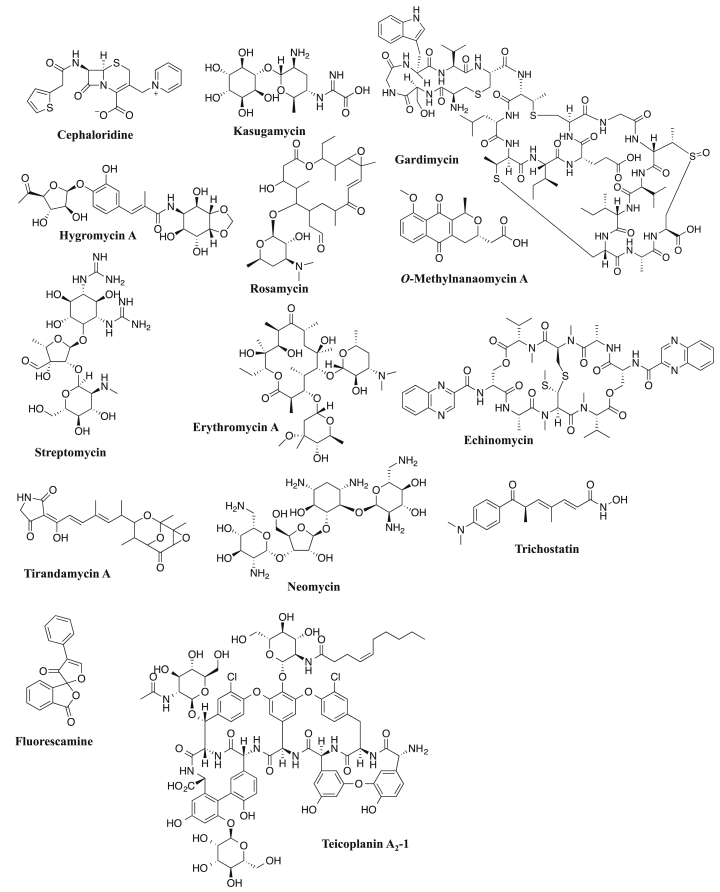
Structures of EhPanK inhibitors identified in this study.